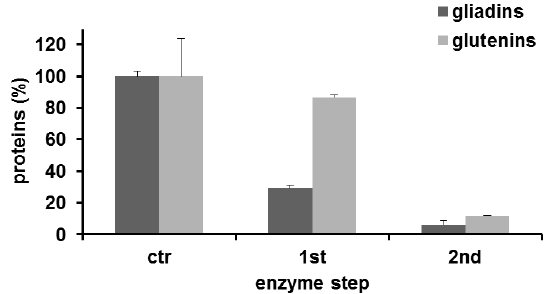
Figure 1. Assessment of the residual gliadin and glutenin protein fractions following the transamidation reaction, purified according to the modified Osborne procedure. Each bar represents values (means ± SD) calculated as the percentage of control (untreated semolina) of triplicate experiments.